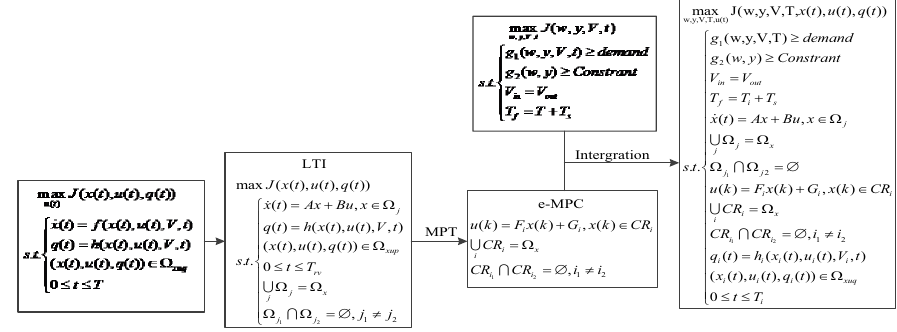
Fig. 1. Integration of scheduling and control framework.